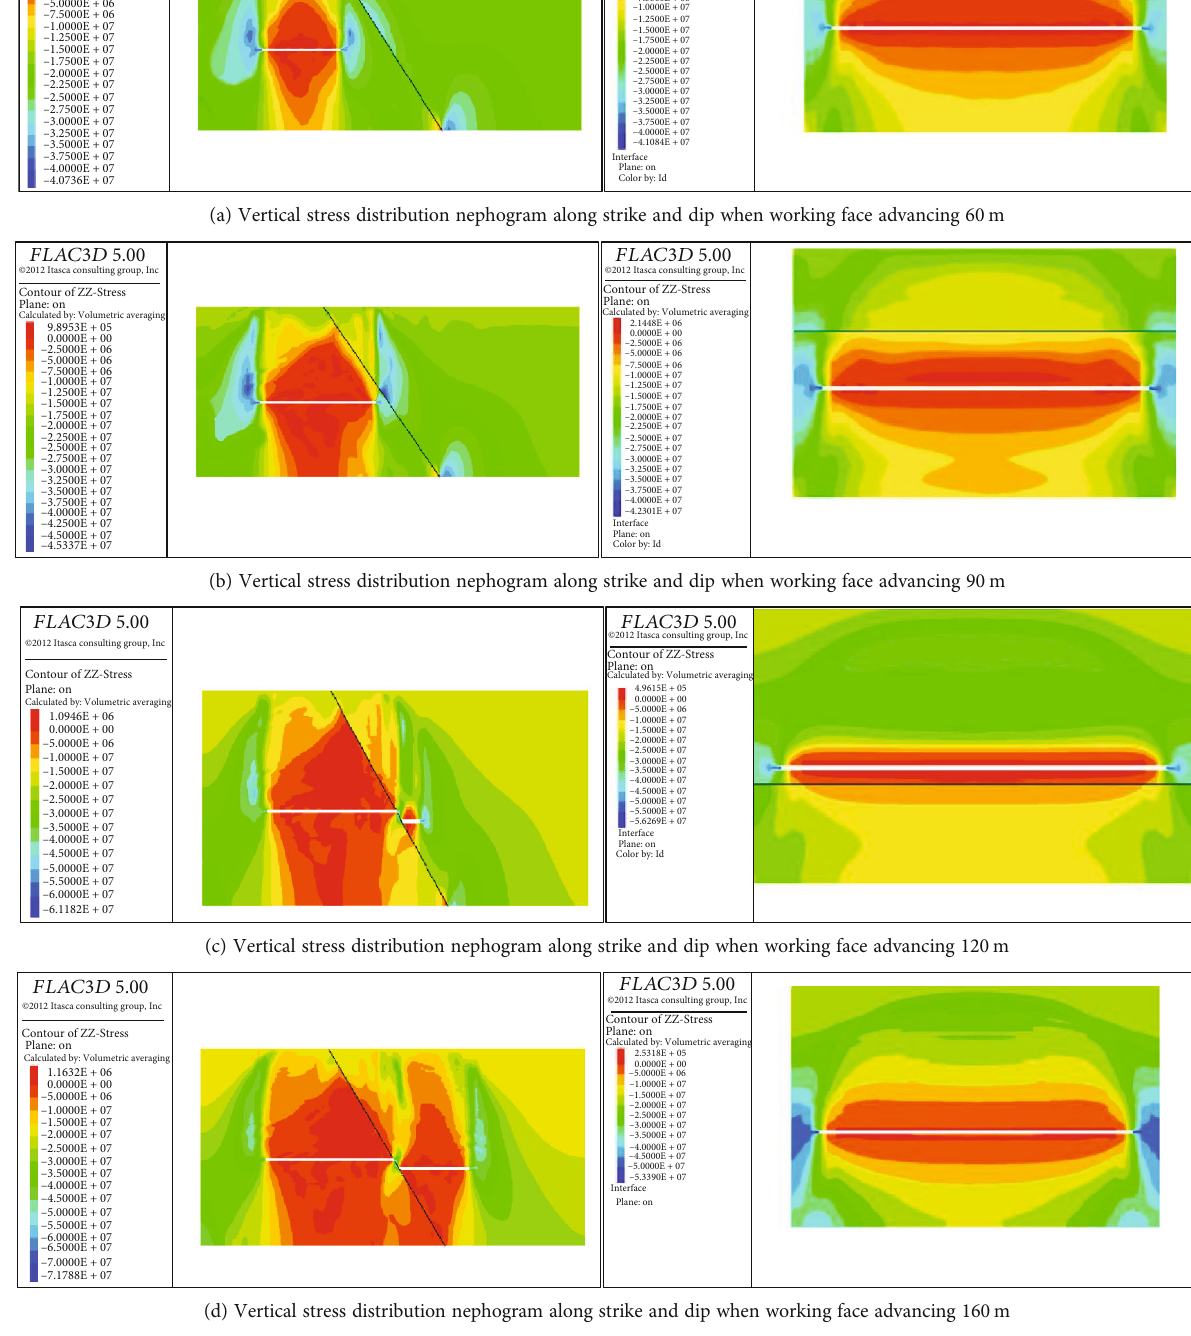
Figure 10: The distribution nephogram of vertical stress along tendency and strike under di ff erent advancing